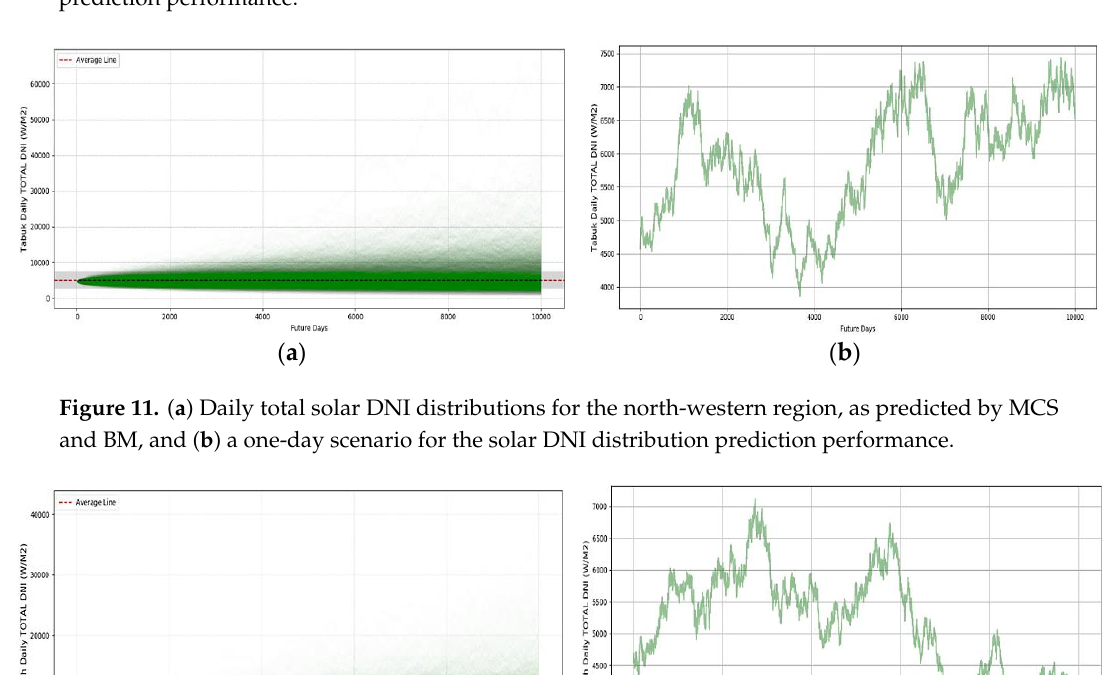
performance. prediction performance.